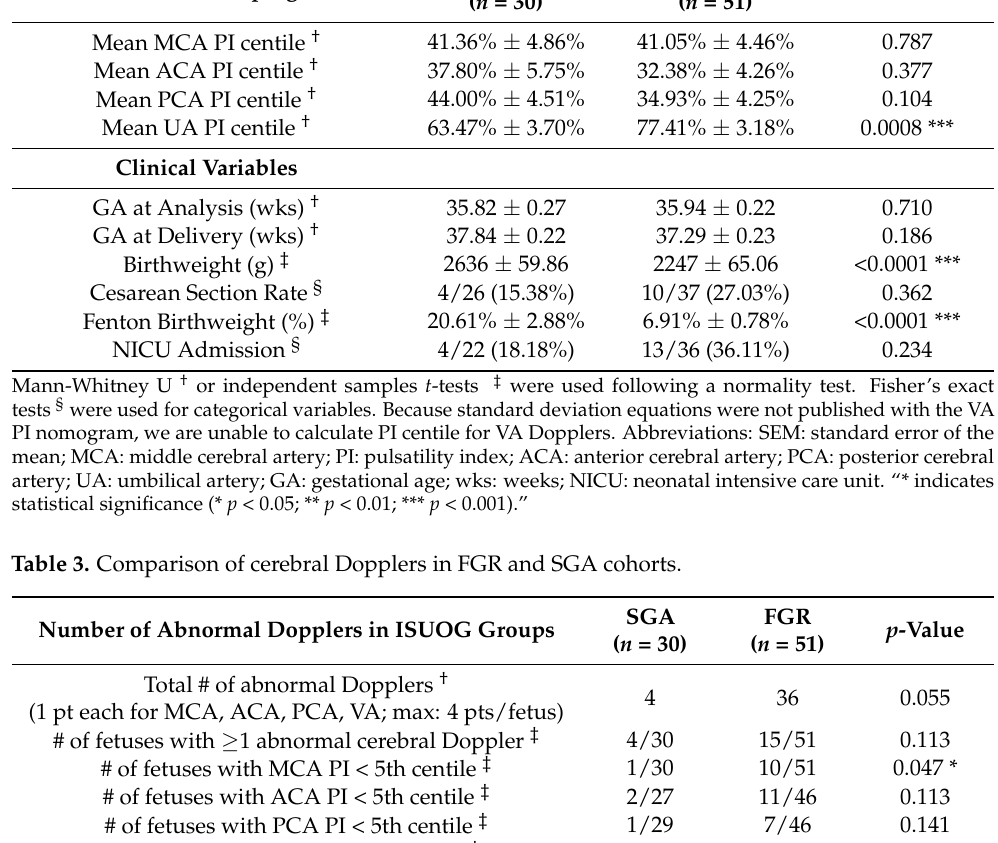
Table 2. Comparison of patient characteristics in FGR and SGA cohorts. Cerebral Dopplers between